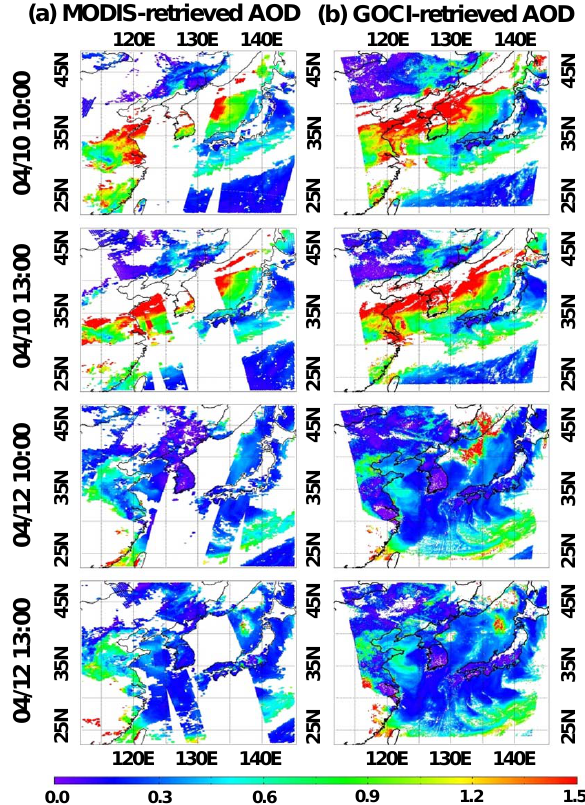
Fig. 2. Snapshots of (a) Terra and Aqua/MODIS-retrieved AODs and (b) GOCI-retrieved AOD over Northeast Asia at 10:00LST (Terra/MODIS) and 13:00 LST (Aqua/MODIS) on 10 April and 12